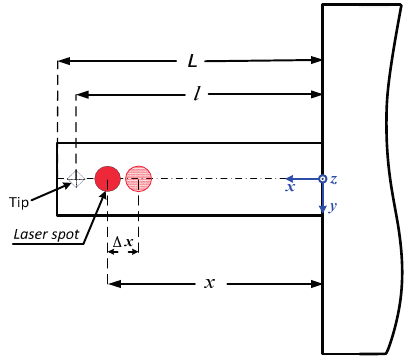
Figure A1. Schematic drawing of a rectangular beam model with laser spot on